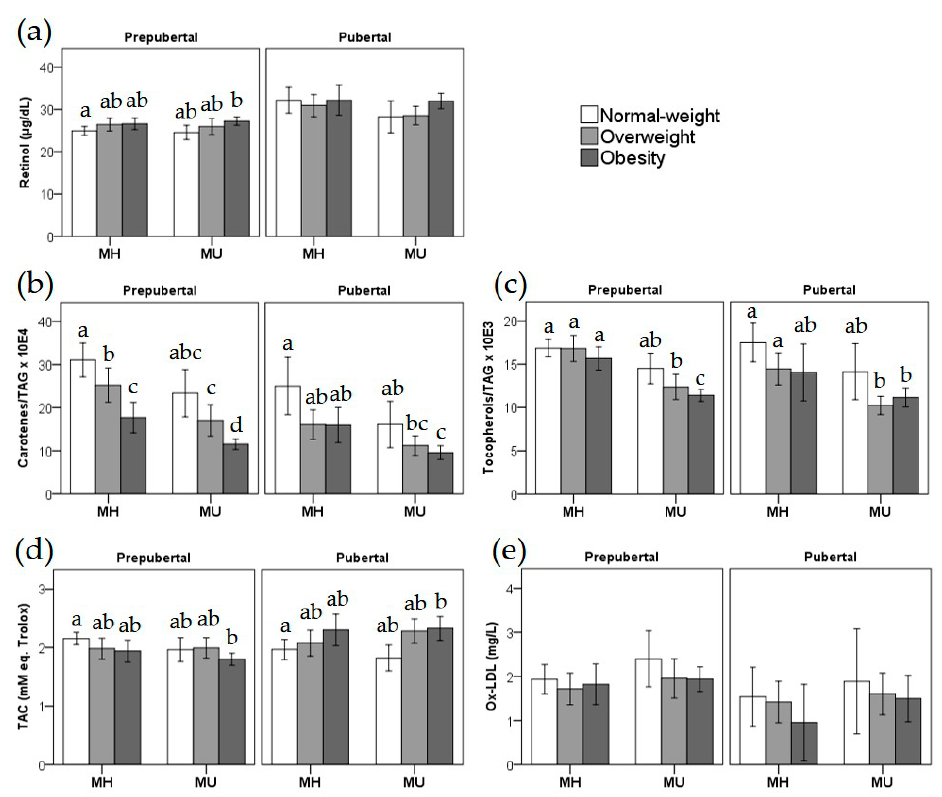
Figure 1. Mean values of plasma retinol ( a ), carotenes/TAG ( b ), tocopherols/TAG ( c ), TAC ( d ), and ox-LDL ( e ) of prepubertal and pubertal children, according to their weight categories (normal-weight, overweight, and obesity) and metabolic health (healthy or unhealthy) status. Within each pubertal category, different letters indicate significant differences at p < 0.05 in pairwise comparisons of the general linear model adjusted for sex, age and recruitment center, (sharing the same letters indicates no significant differences between groups, absence of letters indicates no significant differences between any of the groups). MH: metabolically healthy; MU: metabolically unhealthy; ox-LDL: oxidized low-density lipoprotein; TAC: total antioxidant capacity; TAG: triacylglycerols.